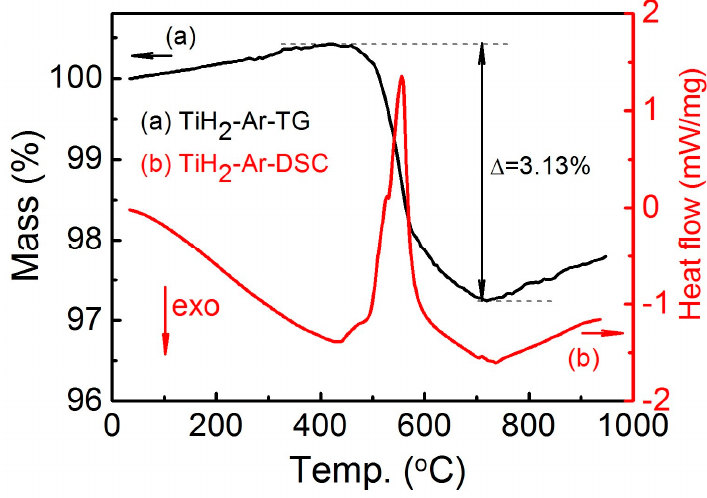
Figure 9. The ( a ) TG and ( b ) DSC of TiH 2 powder heated to 1000 °C under flowing Ar.